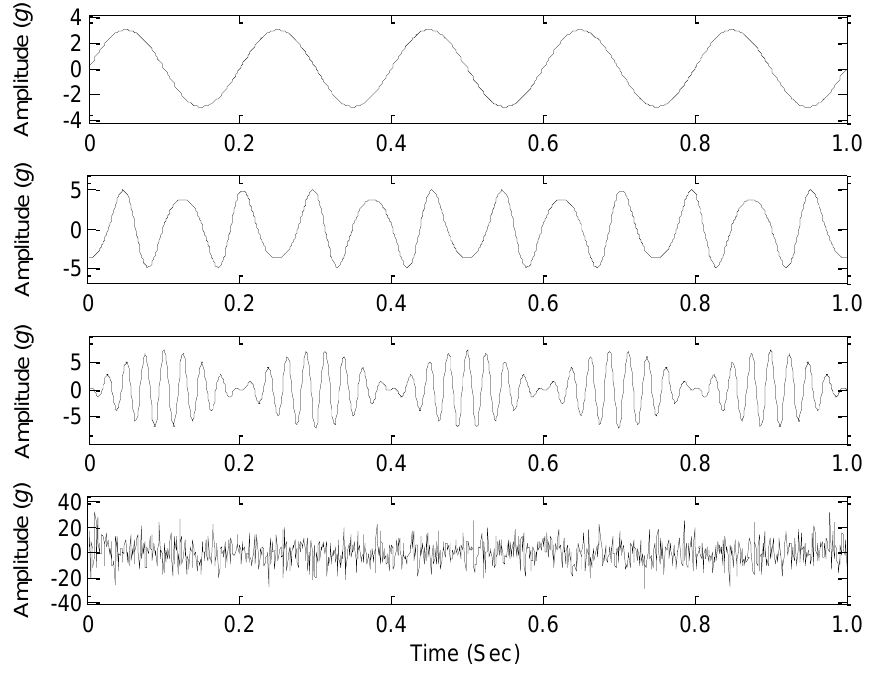
Figure 1. The waveforms of the source